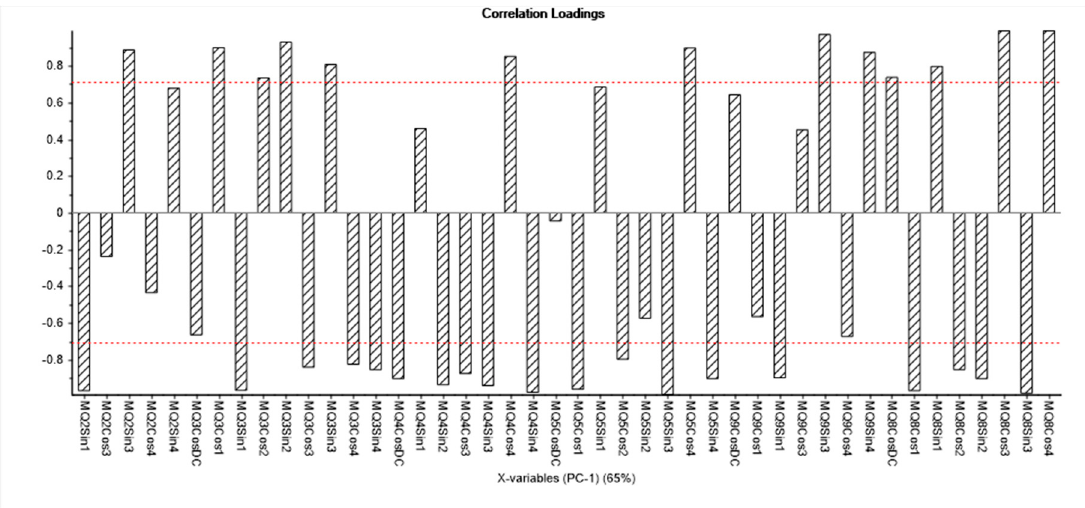
Figure 5. Readings from sensor array (with error bars).